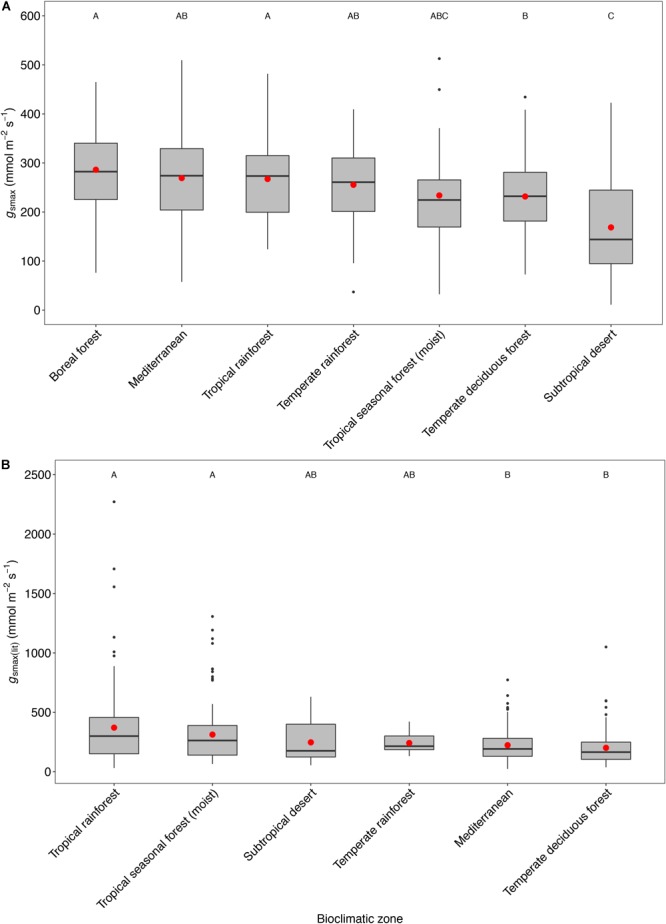
Boxplots comparing maximum stomatal conductance across bioclimatic zones for this study (A) in combined open-canopy and understory-subcanopy gsmax data and for published literature (B) from Maire et al. (2015) for gsmax(lit) data. Boxplots are arranged from the highest to the lowest average value. Capital letters above boxplots indicate pairwise comparison across bioclimatic zones using Tukey’s honest significant difference (P < 0.05), (the same letter means the variables are not significantly different while a different letter means they are significantly different). ANOVA was used to analyze differences across bioclimatic zones. Boxes represent the interquartile range (IQR), horizontal line within boxes represents the median, the red dot represents the mean and whiskers extend to 1.5 times the IQR; black dots are outliers.